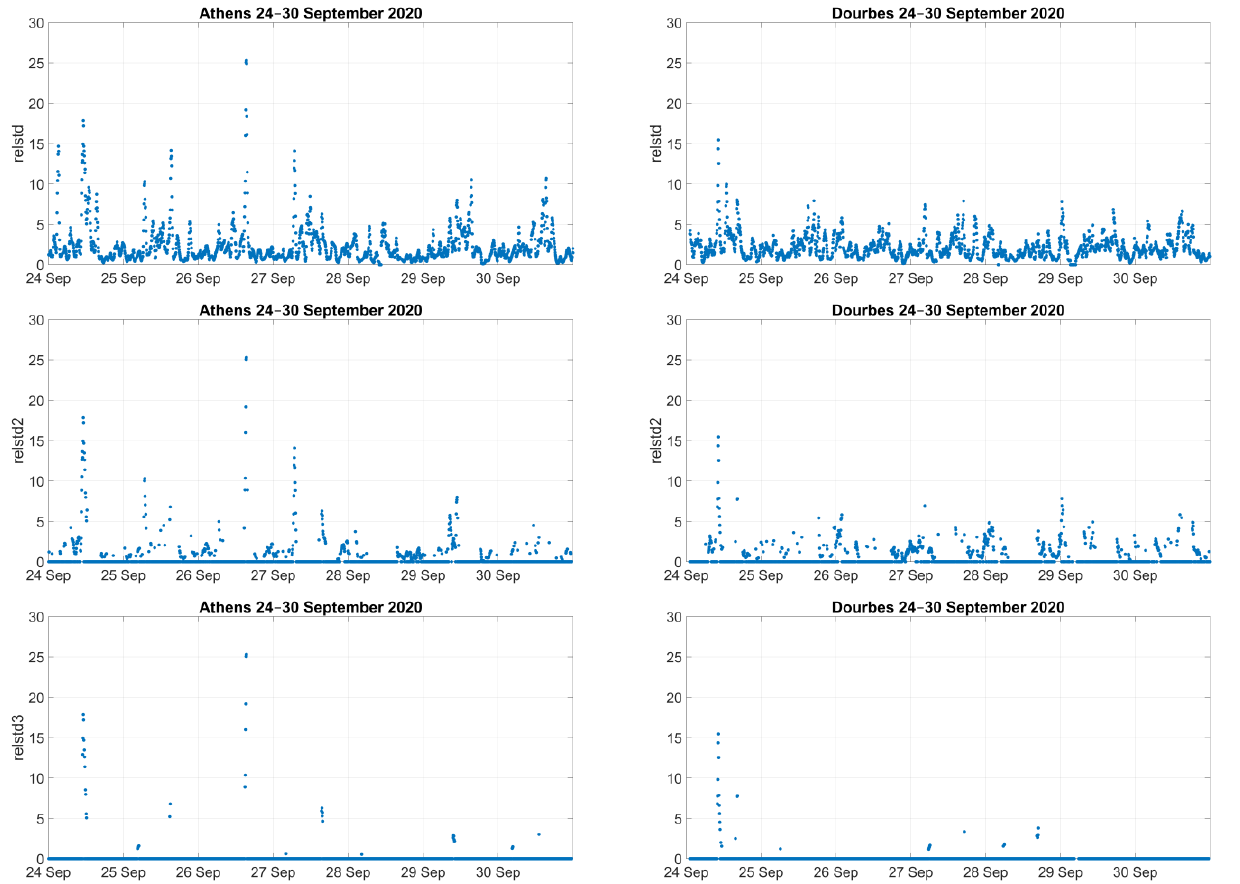
Figure 8. The application of LSTID identification criteria for 24–30 September 2020, similarly as in Figure 6, over data collected from Athens ( left ) and Dourbes ( right ) manually scaled ionograms.